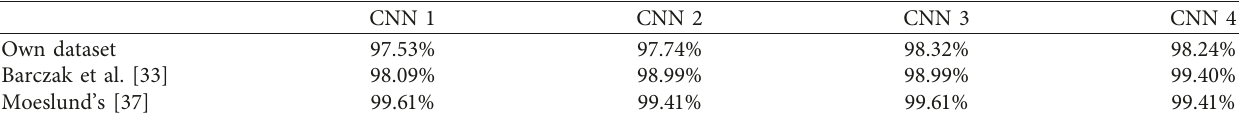
Figure 17: Accuracy and loss during ResNet50 training and validation. Table 4: Results obtained for each dataset individually using the proposed